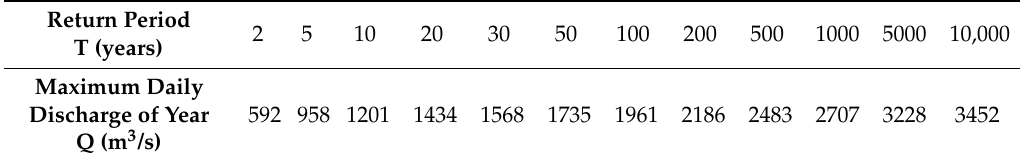
Figure 2. Horizontal alignment of the Greek part of the Arda river (source: Google Earth). The border lines at east and west are indicated with yellow lines, while the river levees are shown with red lines. The positions of the monitoring station (after the dam of Ivaylovgrad) and of the calibration point (near the village Komara) are also indicated. Arda river maximum daily discharges as a function of return periods at the Greek-Bulgarian